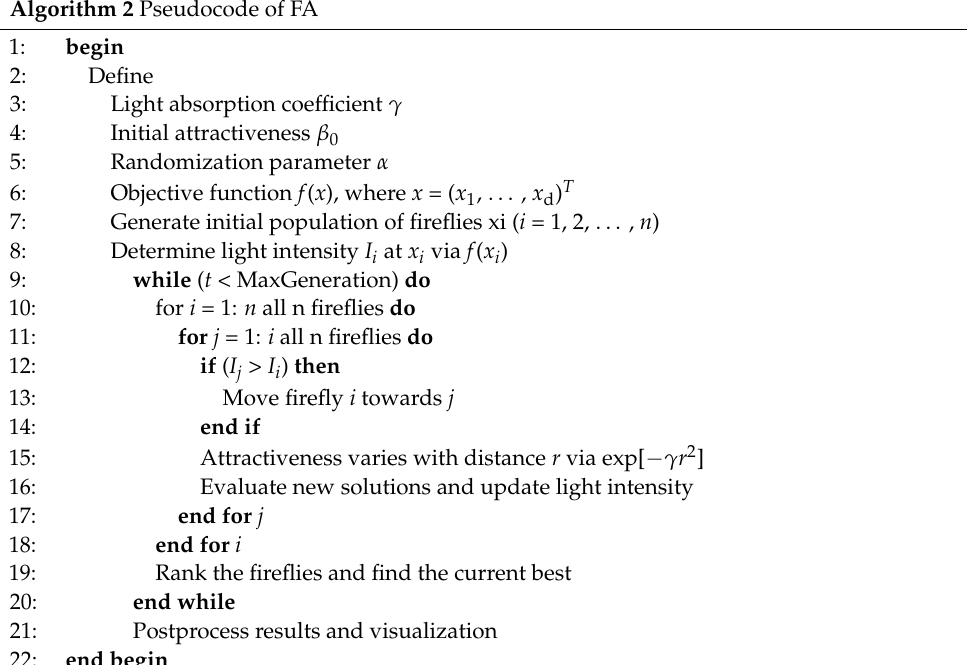
Algorithm 2 Pseudocode of